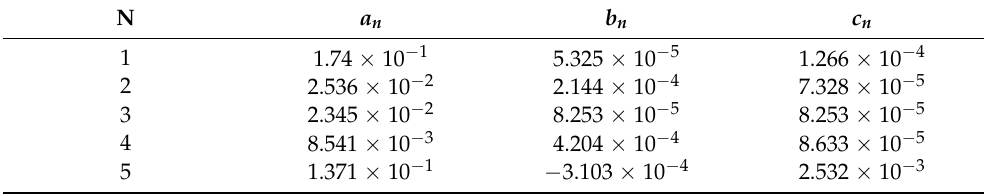
Table 2. Coefficients in Equation